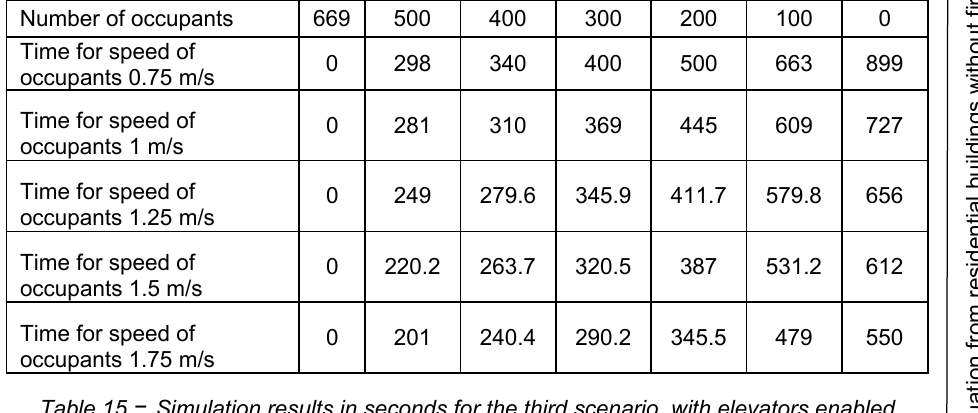
Table 15 – Simulation results in seconds for the third scenario, with elevators enabled and the second and the fourth entrances/exits blocked and for the occupants’